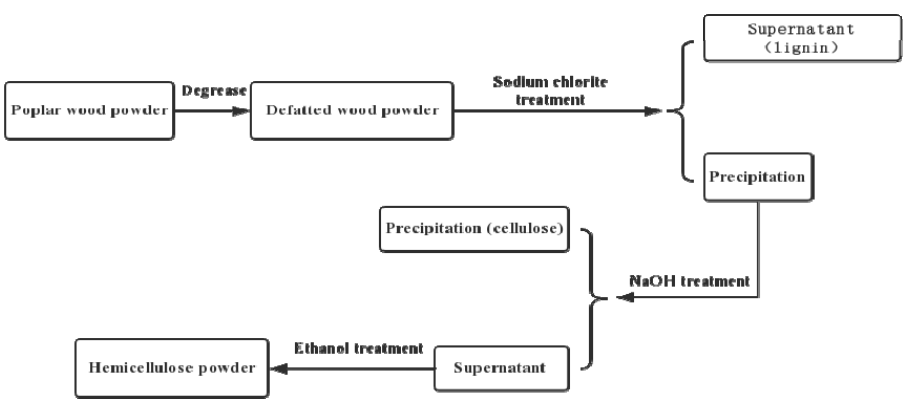
Figure 1. The flow chart of hemicellulose extraction.